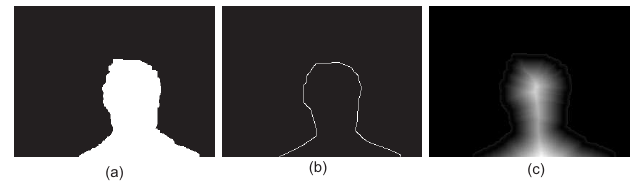
Figure 1. Generation of shape priors for the segmentation. (a) The silhouette providedbythegaitrecognitionmodule; (b)theEdgedetectionresult; and (c) the Euclidean distance transform